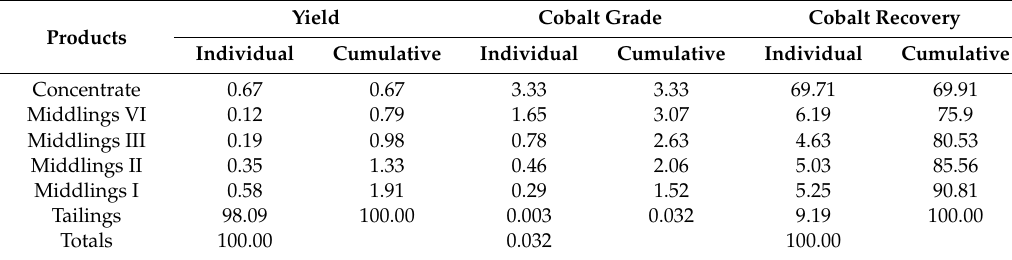
Table 5. E ff ect of cleaning time on cobalt grade and recovery in flotation